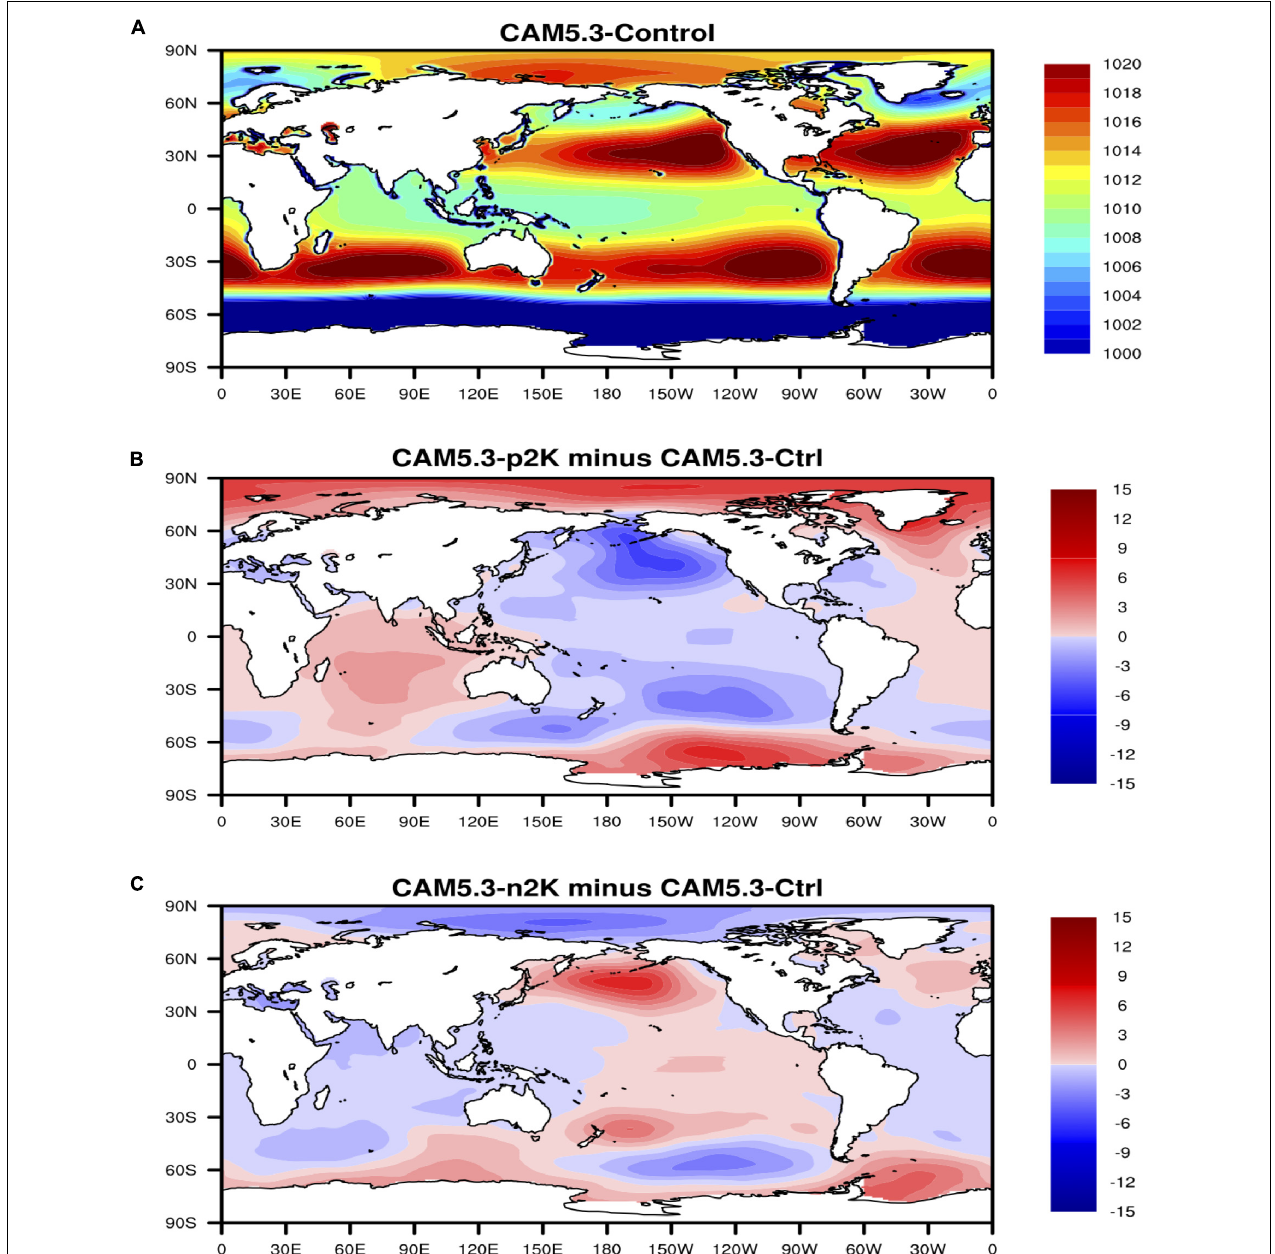
FIGURE 8 | (A) Sea level pressure in the CAM5 control run. (B) Anomalies of SLP in the CAM5 + 2K run with respect to the control run. (C) Anomalies of SLP in the CAM5-2K run with respect to the control run. Unit of SLP is hPa.